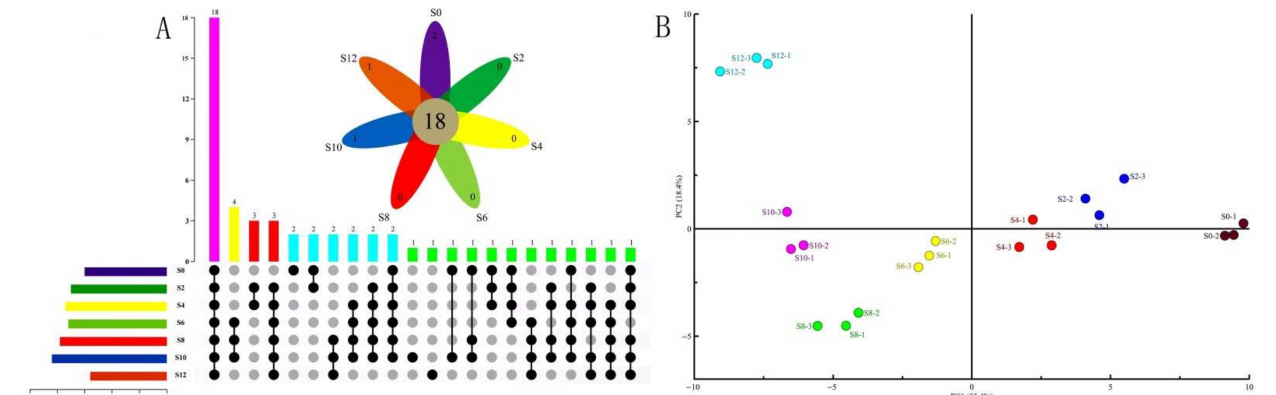
Figure 3. Venn diagram ( A ) and principal component analysis (PCA) ( B ) of volatile compounds from apricot juice during seven fermentation periods. S0, S2, S4, S6, S8, S10 and S12 represent fermentation for 0 h, 2 h, 4 h, 6 h, 8 h, 10 h and 12